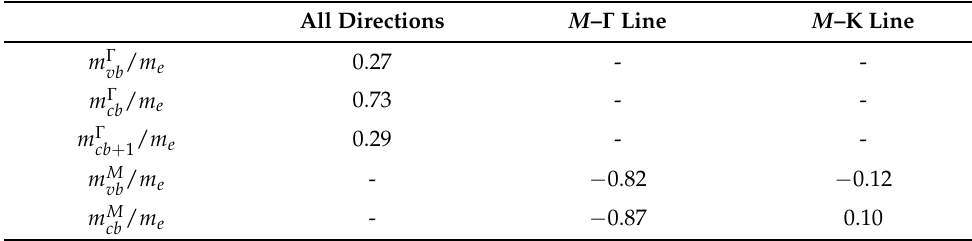
Table 1. Effective masses at the Γ and M points. All